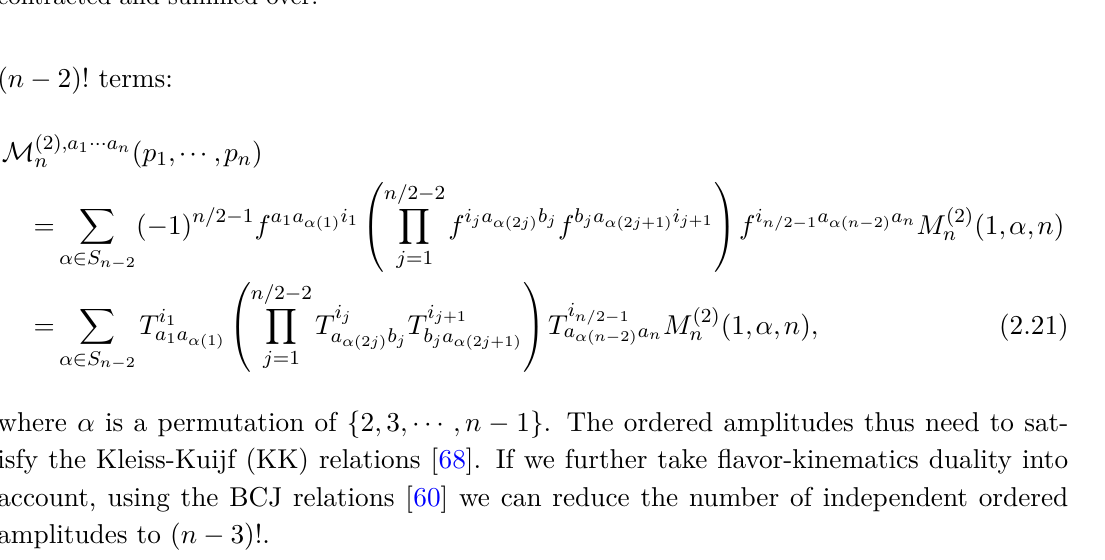
Figure 2 . The flavor factors in the DDM basis. The internal lines represent the indices that are contracted and summed